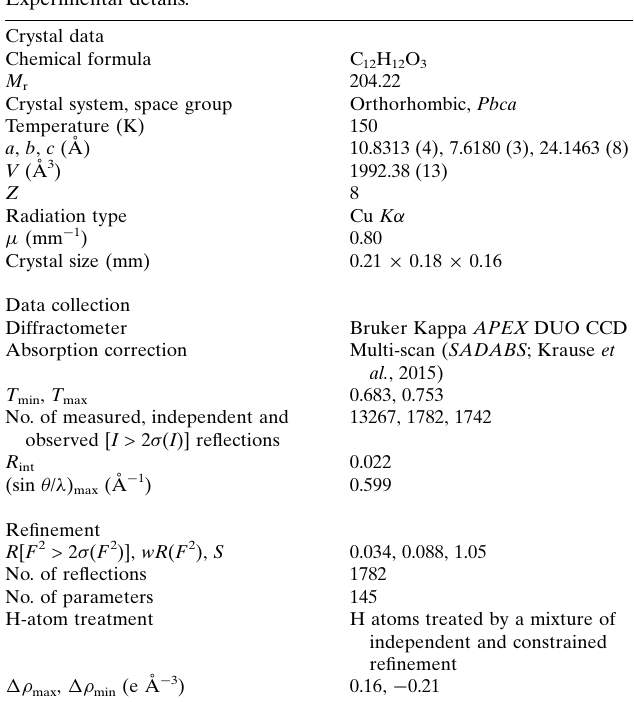
Table 2 Experimental details.